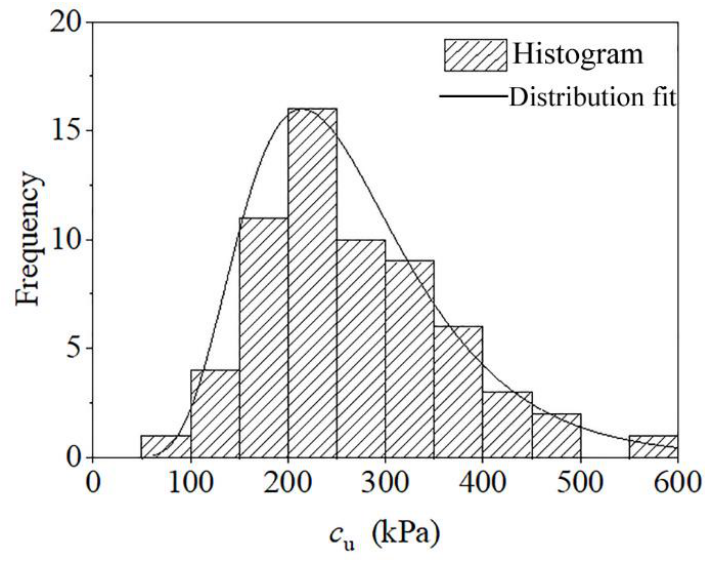
Figure 15. Histogram and the distribution fit of the undrained shear strength. Random field modeling of geotechnical spatial variability often decomposes the variation of geotechnical properties into the trend function (e.g., linear function in this study) and residue (so-called inherent spatial variability). Stationary random fields are then applied to model the residue. In other words, the detrending process is needed to enable the applicability of stationary random fields. Thereby, since there is a tendency of increased shear modulus with increased depth, the estimation of the distribution type has to be carried out under the situation of removing the linear trend. The detrending process is conducted by using MATLAB software. As shown in Figure 16, the right part presents the comparison between the original and detrended data of the secant shear modulus G s from all three boreholes, the left part shows the detrended shear modulus and its histogram. It can be estimated from the histogram that the detrended G s follows normal distributions. When the shear strain is 0.1%, the dominant distribution range of the detrended G s is − 10 to 10 MPa, while the shear strain increases to 5%, G s mainly falls within the range